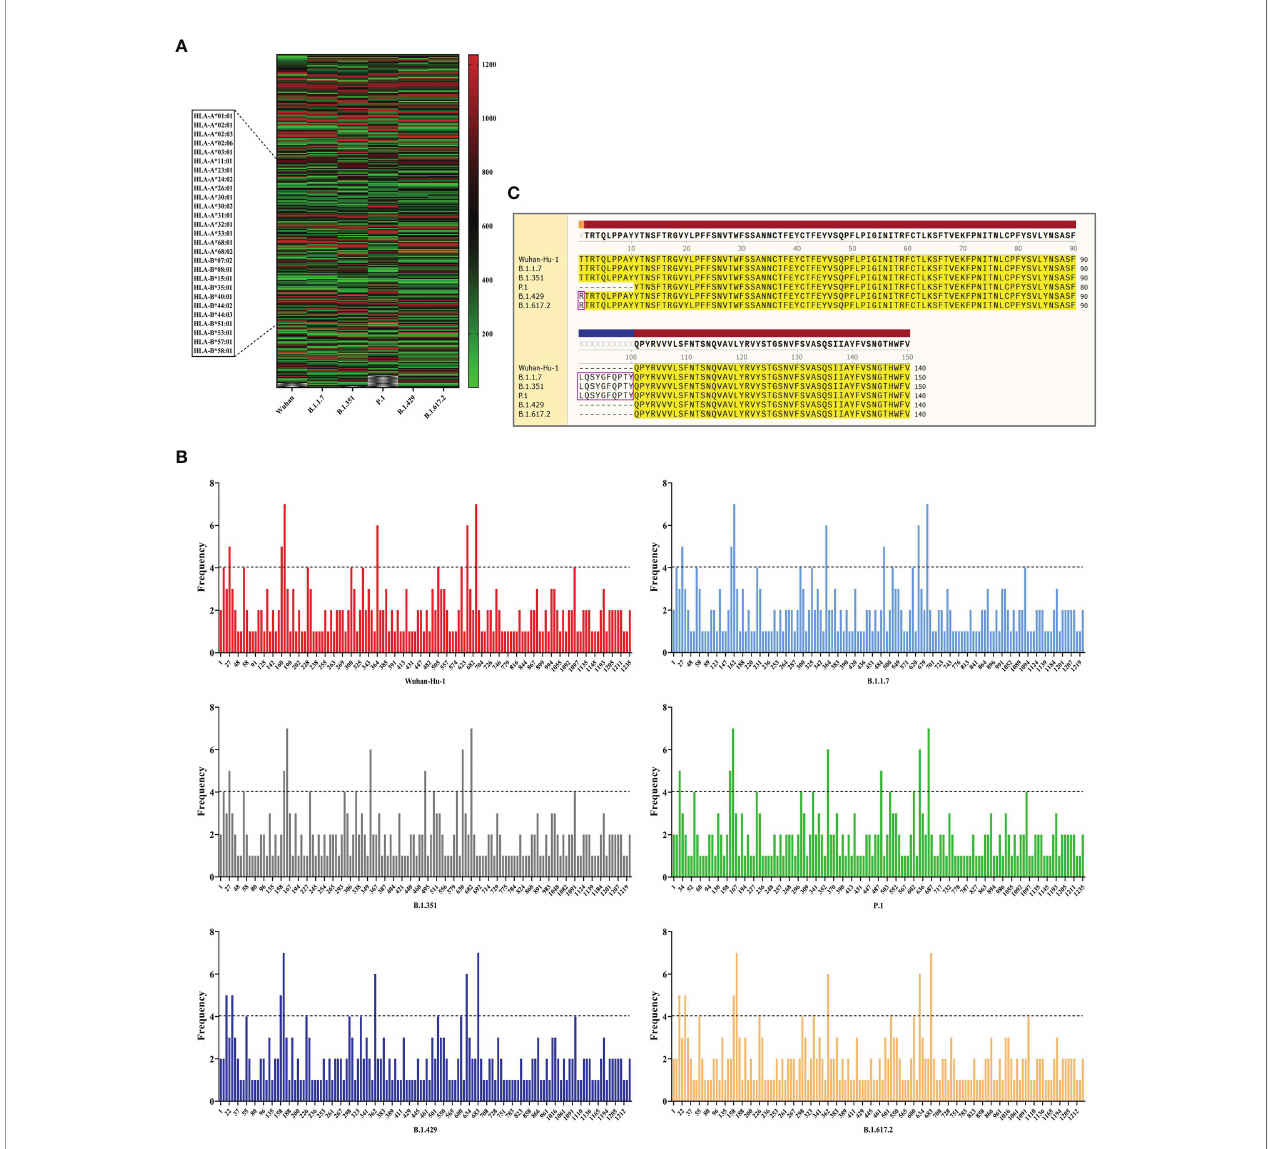
FIGURE 4 | The identi fi cation of CTL epitopes. (A) After identifying the 27 kinds of HLA-I alleles, all the CTLEs of the S protein in the 6 SARS-CoV-2 strains were shown here. The abscissa represents the six virus strains and the ordinate represents the position of the beginning of the epitope peptide. (B) The abscissa represented the position of the beginning of the epitope, and the ordinate represented the frequency of the epitope in the 27 alleles. (C) All epitopes of each virus strain were connected in sequence according to the size of the starting position, and the epitopes that had undergone mutation were in the “ pink ” box. Through sequence alignment, all the common and variant epitopes of all strains were used for vaccine